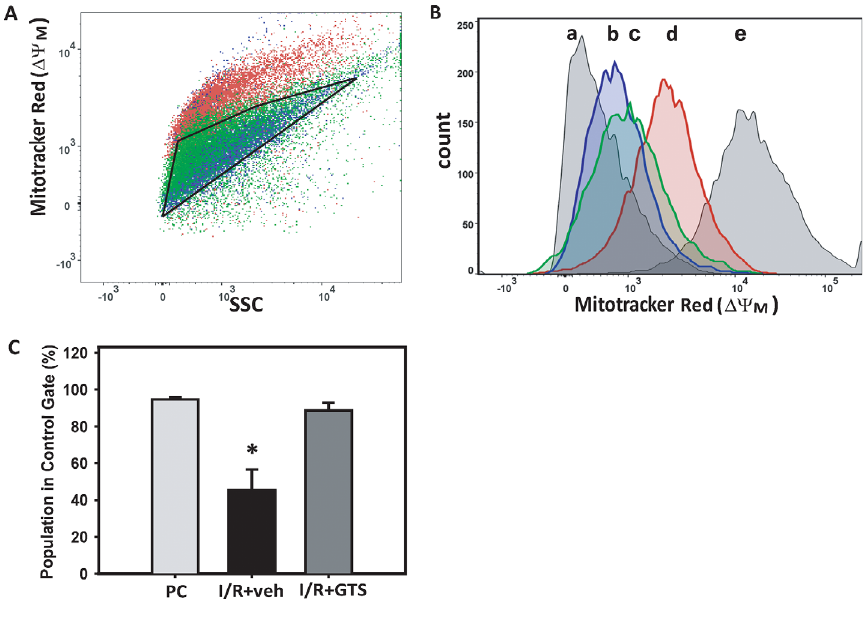
Figure 3. Membrane potential of mitochondria isolated from perfused rat hearts. (A) MitoTracker red dye used to measure mitochondria membrane potential ( ΔΨ m) by flow cytometry. Scatter plot showing individual mitochondria sorted by side scatter (SSC) and fluorescence intensity of MitoTracker dye. Red dots are mitochondria from I/R hearts, blue dots are from perfusion control (PC) nonischemic hearts and green dots are from GTS21- treated I/R hearts. The established gating parameter is indicated by the black lines encir- cling the PC mitochondria. (B) Histograms represent numbers of mitochondria counted and the intensity of MitoTracker red staining of those mitochondria isolated from each treatment group: a, antimycin A–treated mitochondria (hypopolarization); b, perfusion control (PC); c, I/R + GTS21; d, I/R + veh; e, oligomycin A–treated mitochondria (hyperpo- larization). (C) Bar graph quantifying the percentage of total mitochondria in each treat- ment group that fell within the gating parameters established for the perfusion control mitochondria. Values are mean ± SE; PC, n = 3; I/R + GTS, n = 6; I/R + veh, n = 6